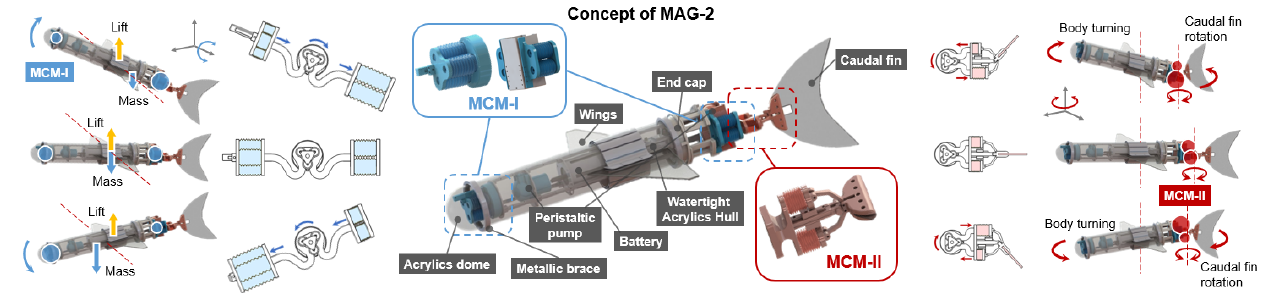
Figure 2. Concept of MAG-2 glider, with MCM-I and MCM-II controlling the pitch and turning, respectively.